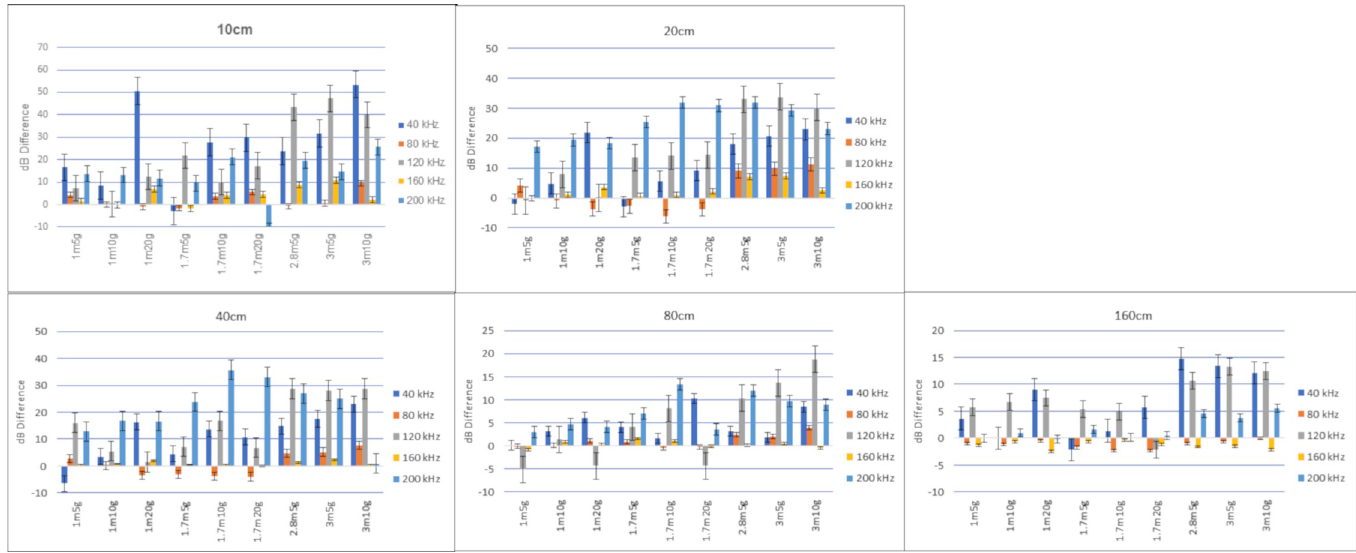
Fig 6. Signal response difference graphs of the smooth model compared to the nine models with grooves. Amplitude in decibels (dB) at 5 different frequencies comparing 9 different pinna models (see Table 1) to that of the smooth model. Each model was exposed to a 40 kHz continuous tone with five harmonics at five different distances. When smooth model amplitudes are more intense, they drop below zero.